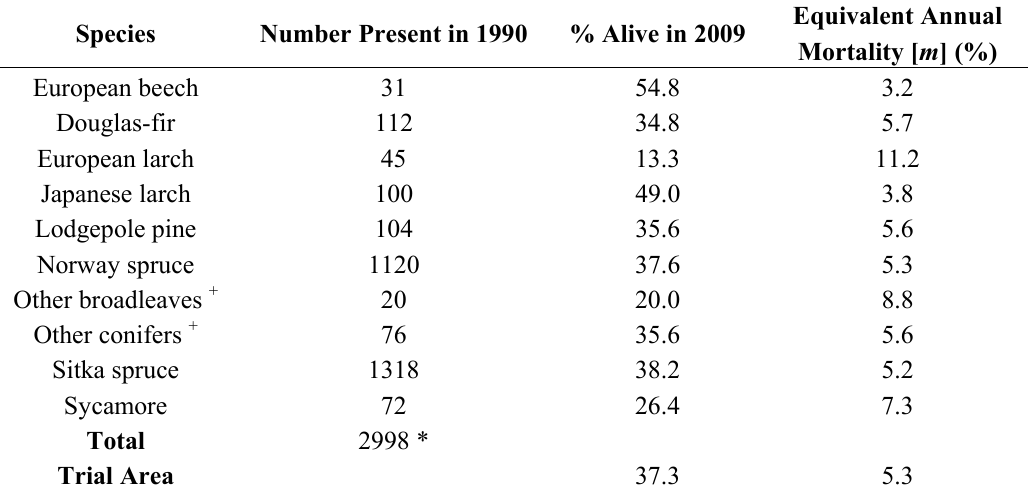
Table 2. Survival of different species between 1990 and 2009 of categories 1–4.